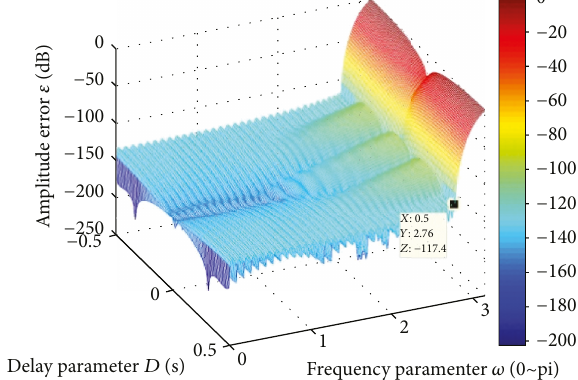
Figure 5: Error with weight function by